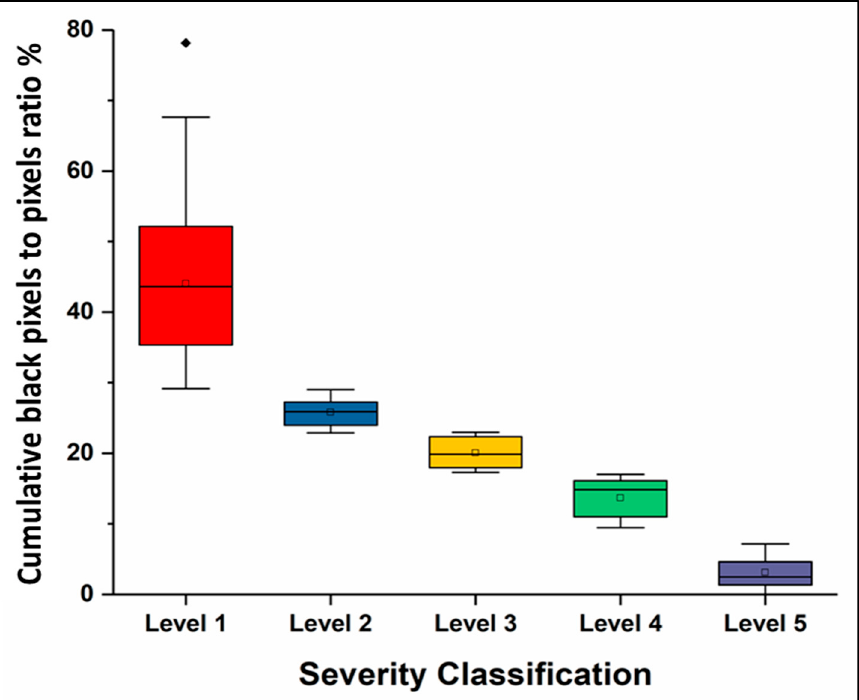
Figure 5. Box plot represents the severity levels of the disease based on the data retrieved from the X-ray images and the cumulative black pixels to total pixels in the ROI. X-ray images and the cumulative black pixels to total pixels in the ROI. Table 2. Accuracy comparison for the proposed model and other published models for a similar Table 1. Quantitative statistical evaluation for the outcome of the proposed model against radiologists’ readings. purpose. Statistical Parameters Value